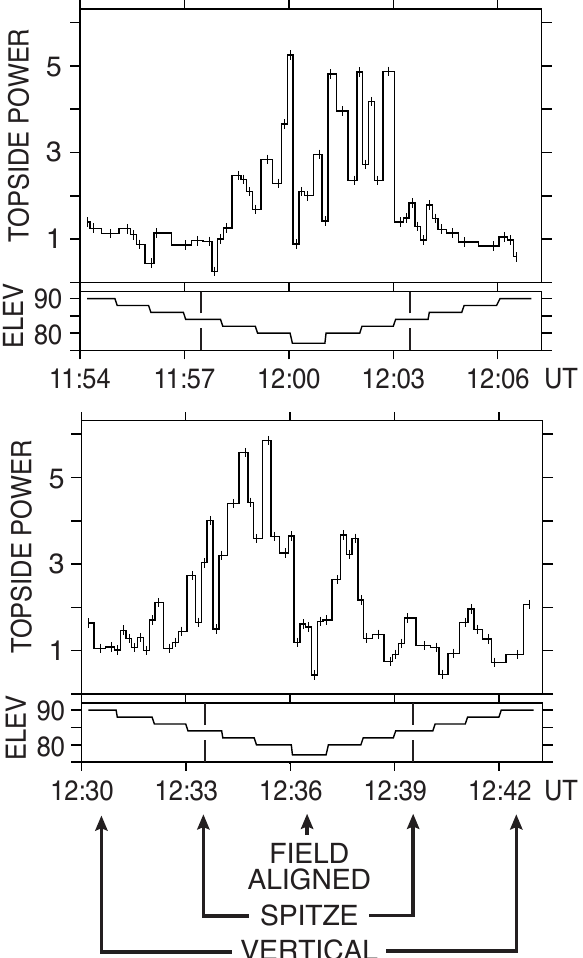
Fig. 3. Topside enhanced ion line power versus elevation angle for two antenna scanning cycles using the EISCAT UHF radar. Repro- duced from Mishin et al. (2001), Fig. 2.